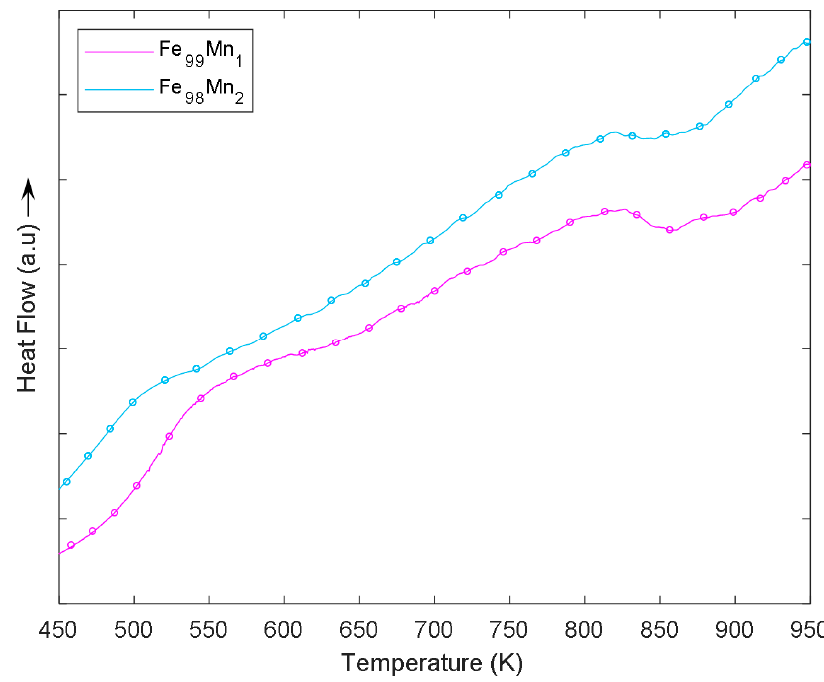
Figure 8. DSC curves for samples Fe 99 Mn 1 and Fe 98 Mn 2 .